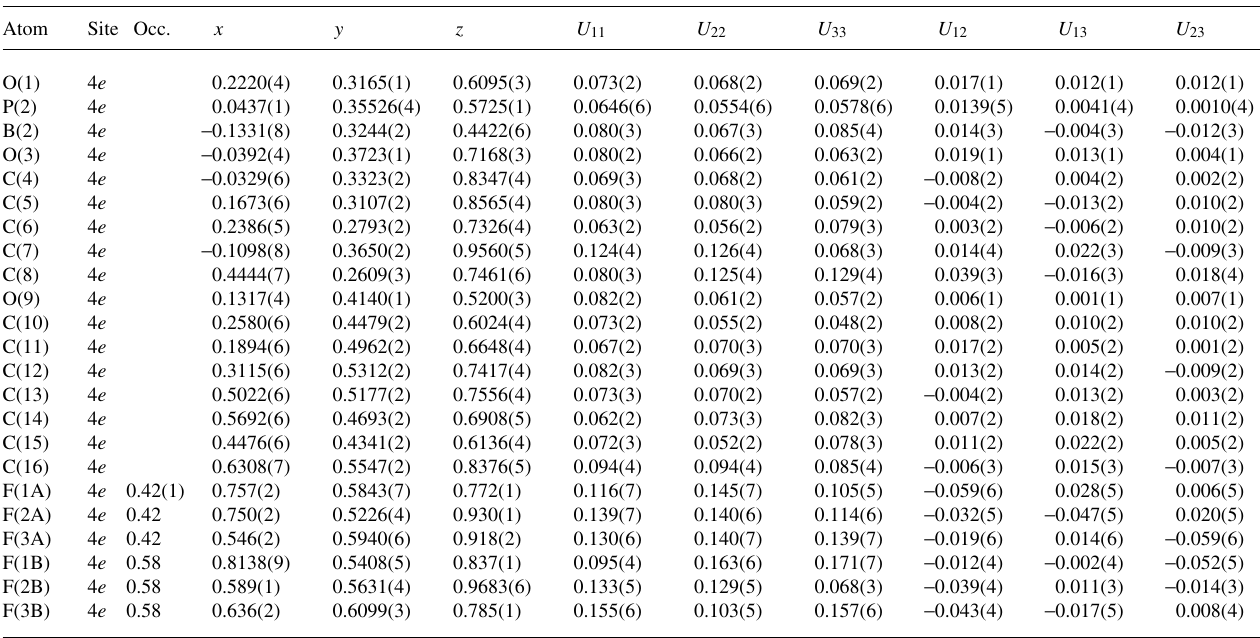
Table 3. Atomic coordinates and displacement parameters (in Å 2 ) .